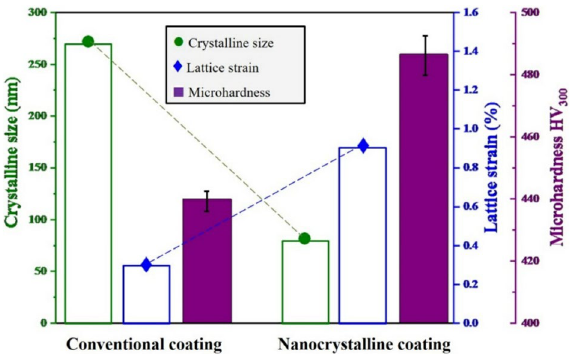
Figure 11. The comparative values of lattice strain and crystallite size estimated by the Williamson–Hall method as well as examined microhardness values of the conventional and nanocrystalline MCrAlY coatings.